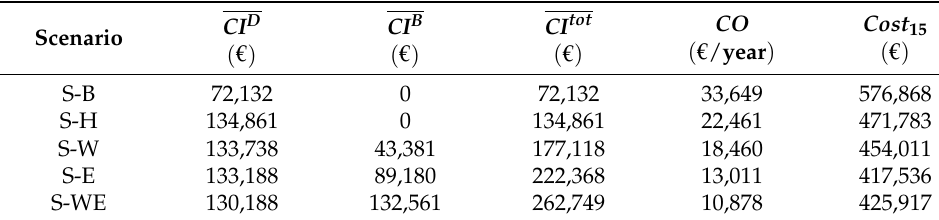
Table 8. Present values of investment and operation results.